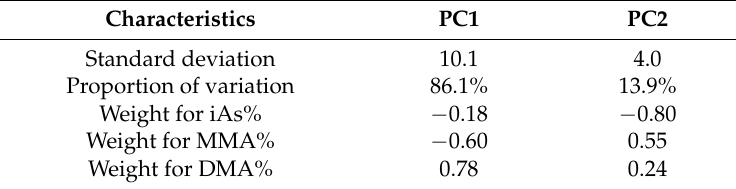
Table 2. Principal components of arsenic metabolites.